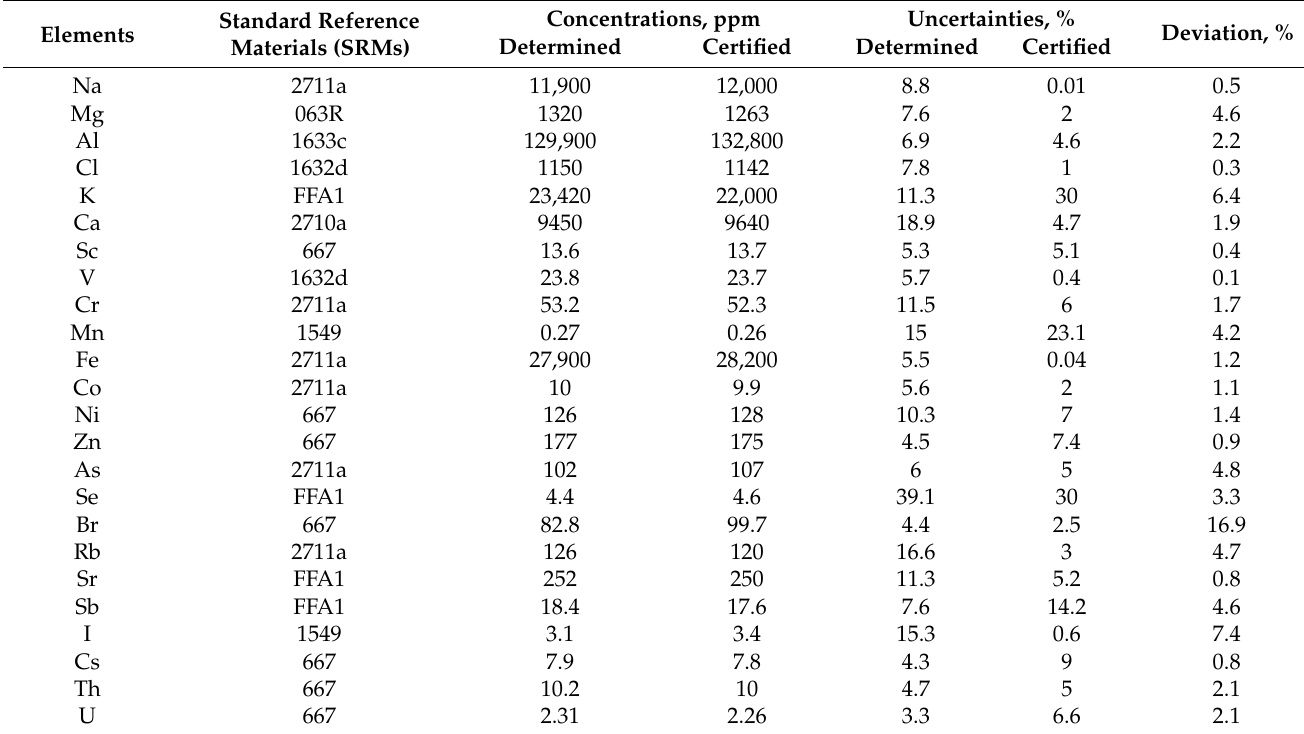
Table 1. Quality control for neutron activation